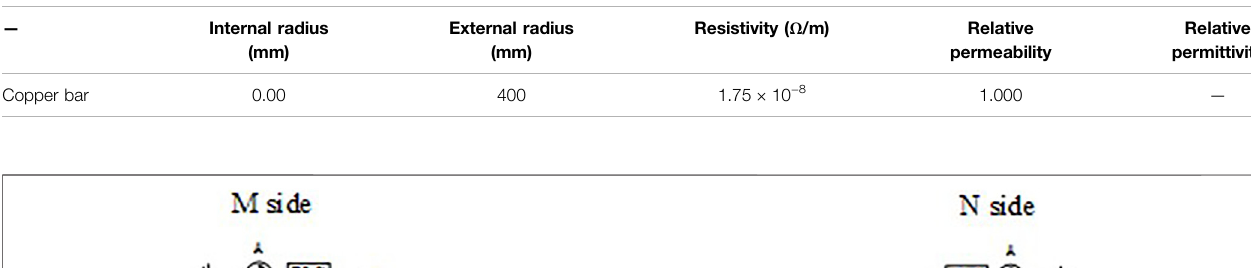
TABLE 2 | Copper bar structural parameters.